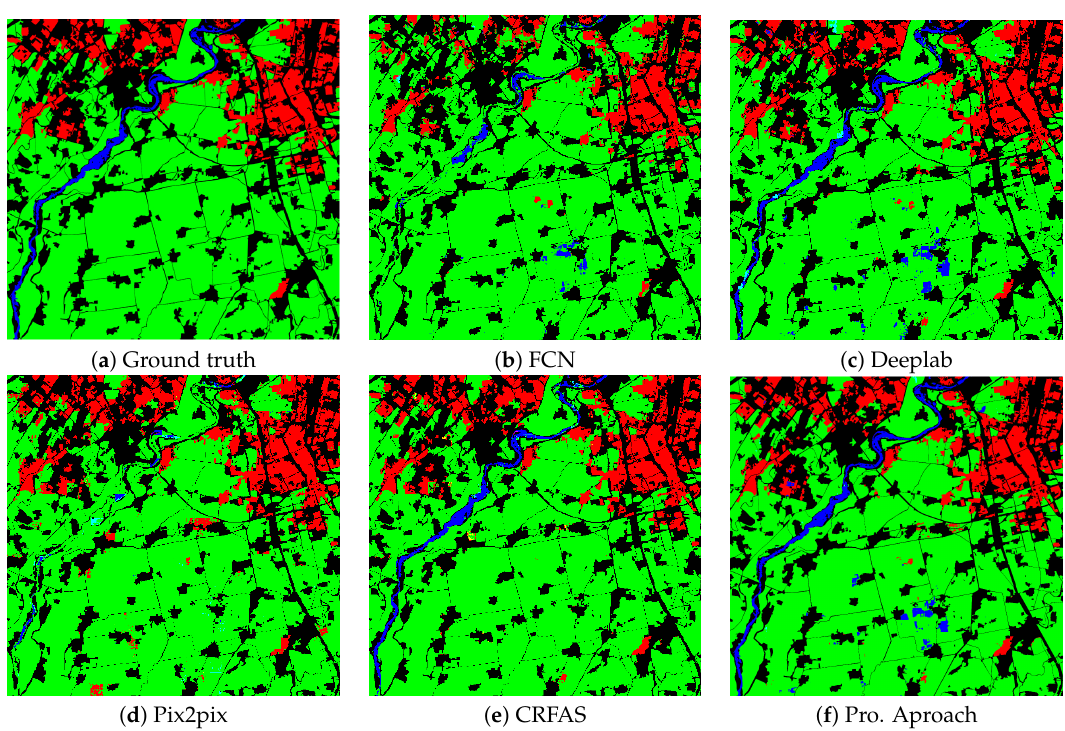
Figure 12. Segmentation results of GID-image3. ( a ) The ground truth; ( b – d ) the results by FCN, Deeplab, and Pix2pix, respectively; ( e , f ) the results by CRFAS and the proposed